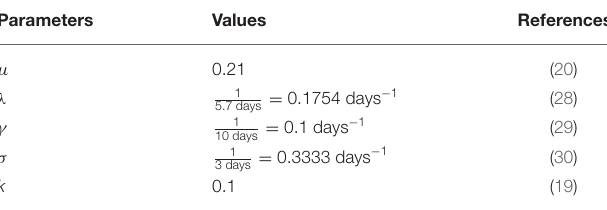
TABLE 2 | Parameters used in numerical simulations and the references. Parameters